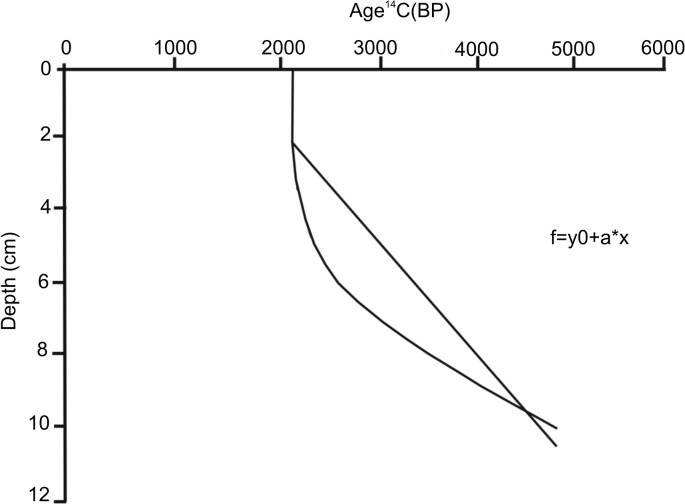
Conventional age.Conventional age (years before present, BP) and best fitting line of surface sediments from Block II on the NW slope of Cuba, Southern Florida Straits.